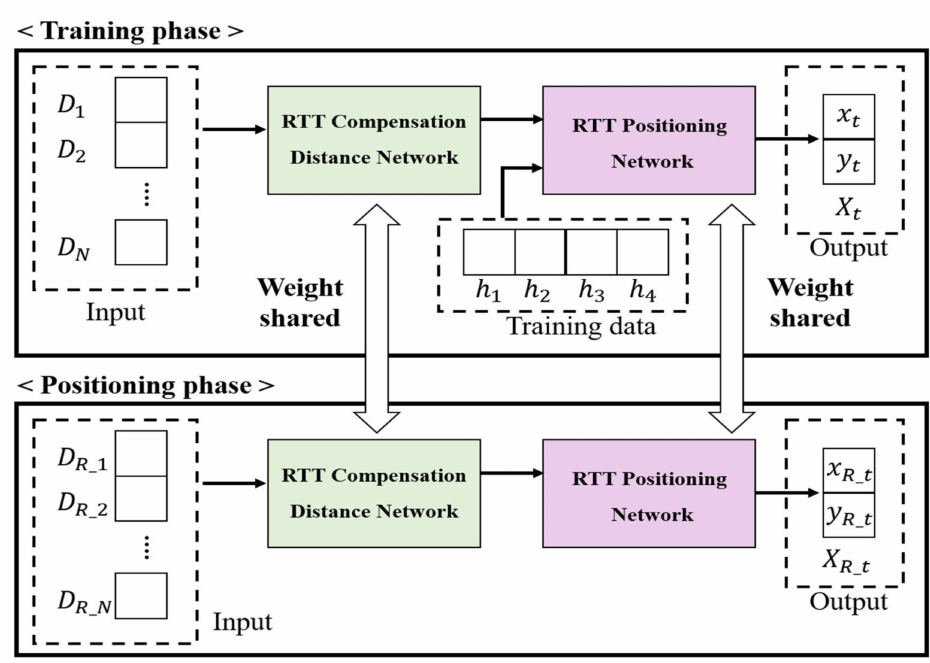
Figure 3. Schematic of proposed